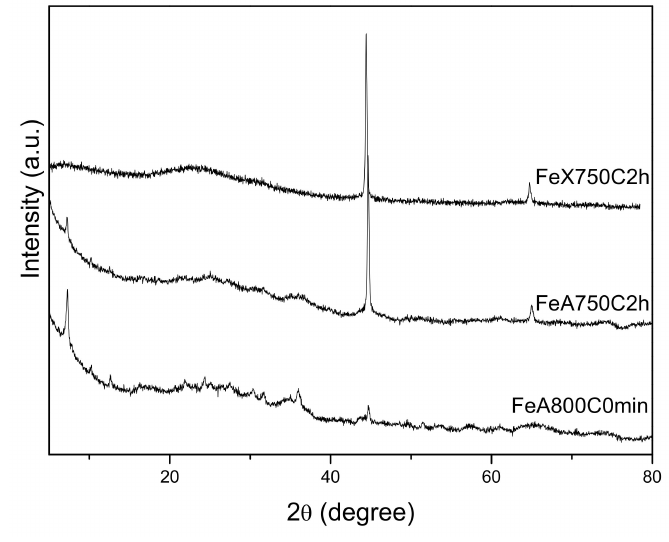
Figure 2. From bottom to top: powder XRD patterns of FeA800C0min, FeA750C2h, and FeX750C2h samples. Table 2. Results of QPA as obtained by Rietveld refinement (phase wt.%). Specific surface area (S BET